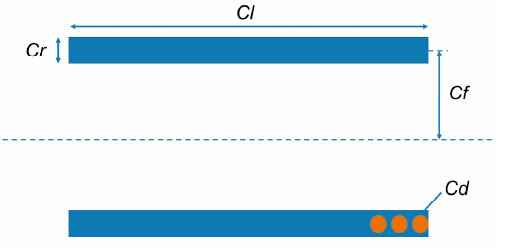
Figure 14. The design variables of